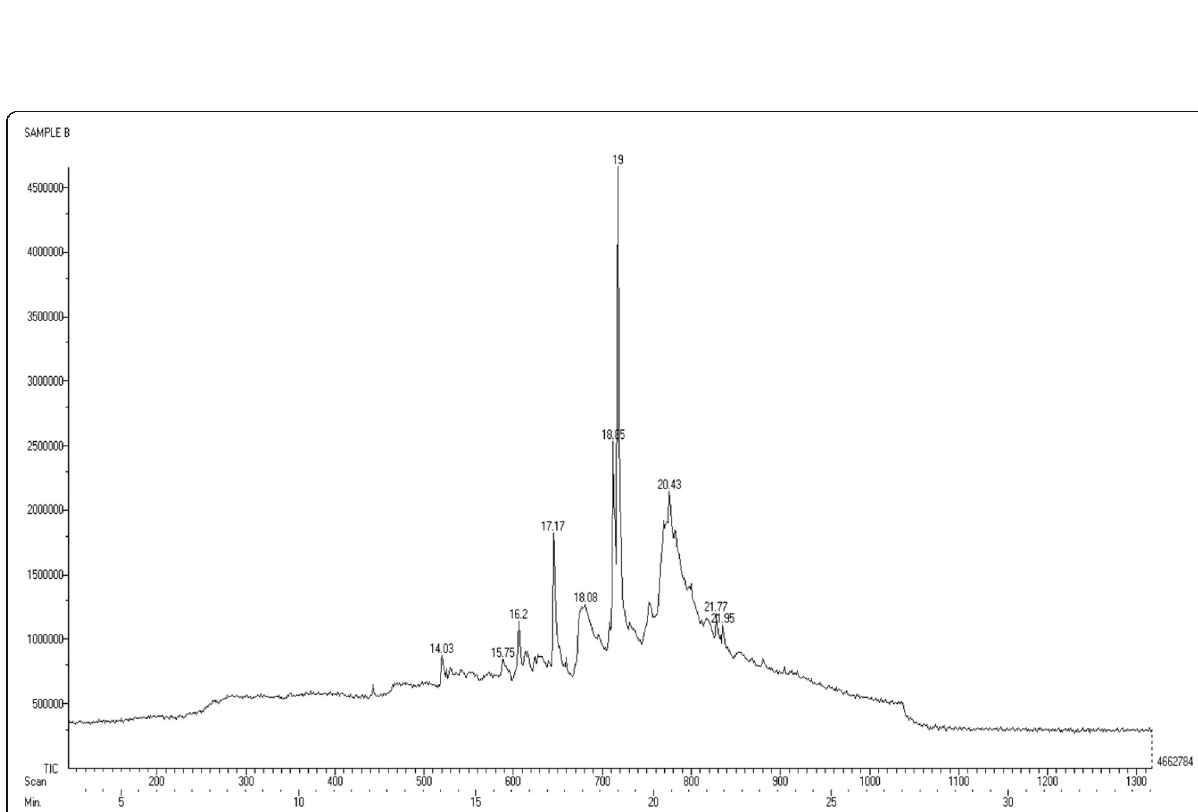
Fig. 10 Gas chromatogrm with mass-spectrometric detection of the methanolic extract of naturally grown L.